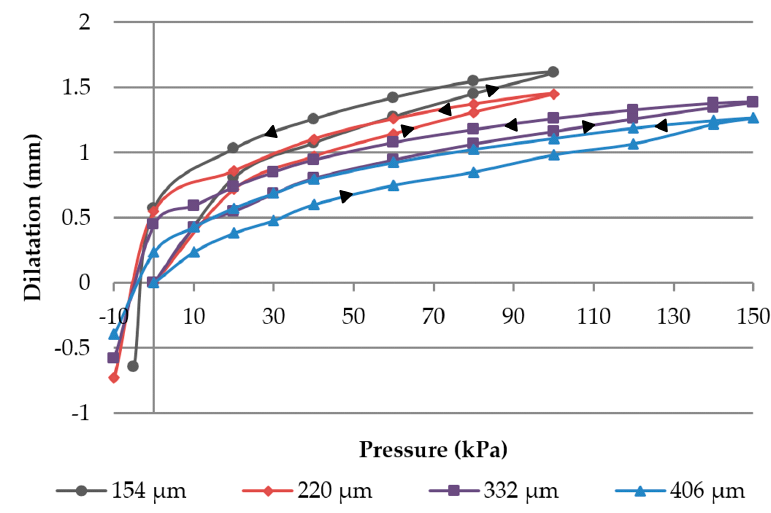
Figure 6. Membrane dilatation of various membrane thicknesses at different pressures (Data from [21]).